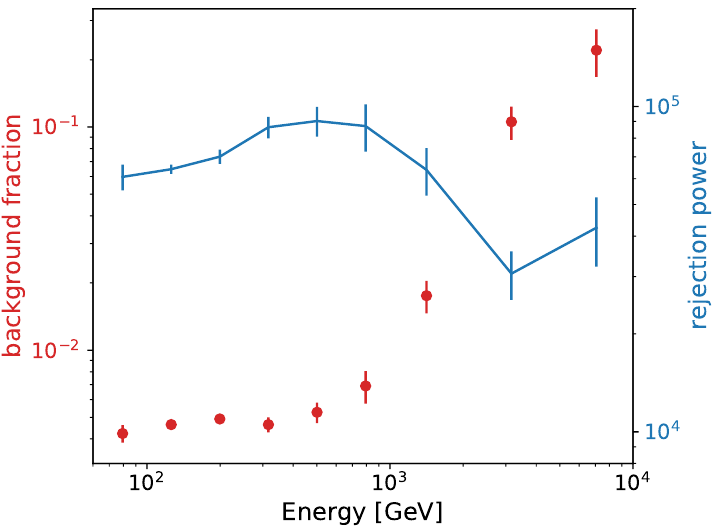
Figure 5. The background fraction is shown by red points (left axis) and a rejection power of protons by blue points with a line (right